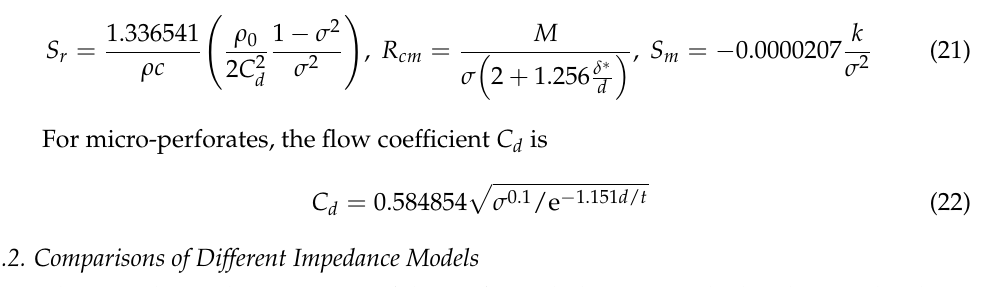
( h ) Figure 2. Comparisons of different impedance models. ( a ) Real part of impedance vs. Mach number; ( b ) imaginary part of impedance vs. Mach number; ( c ) real part of impedance vs. hole diameter; ( d ) imaginary part of impedance vs. hole diameter; ( e ) real part of impedance vs. perforation rate; ( f ) imaginary part of impedance vs. perforation rate; ( g ) real part of impedance vs. Frequency; ( h ) im- aginary part of impedance vs. frequency.